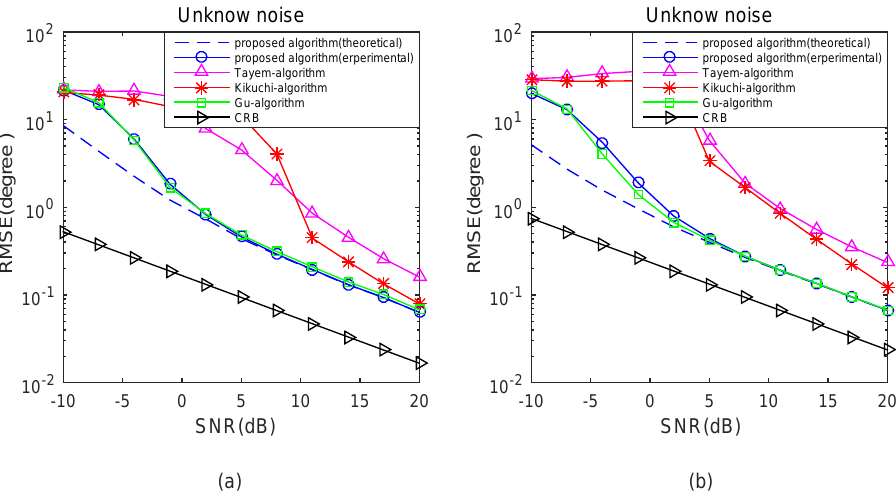
Figure 7. RMSE versus SNR in an unknown noise situation. ( a ) s 1 ( t ) ; and ( b ) s 2 ( t ) .